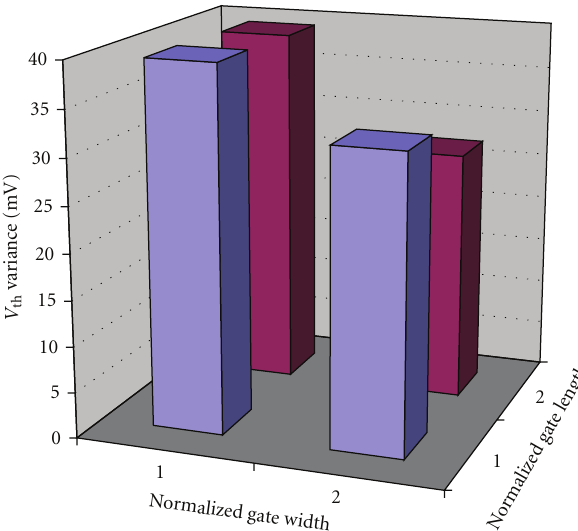
Figure 4: V th variations with di ff erence device sizes (normalized to minimal